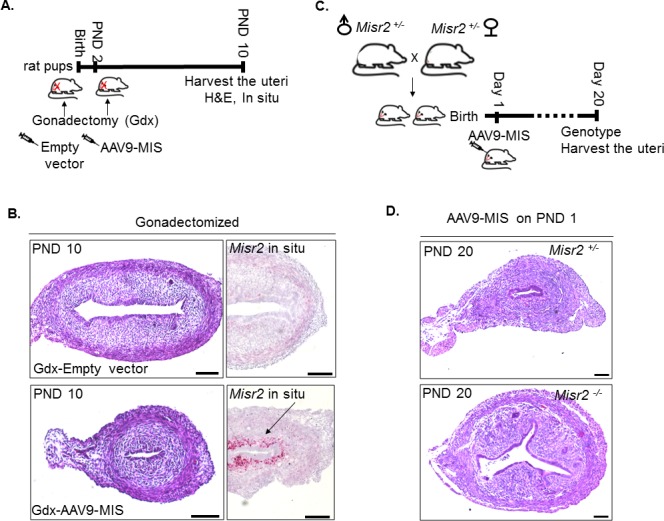
Uterine hypoplasia in response to treatment with exogenous MIS does not require ovaries and is dependent on MISR2.(A) Rat pups were gonadectomized on PND 2, and treated with empty vector (CTL) or AAV9-MIS (MIS) 6 hr after surgery. Gonadectomized (GDX) rats were sacrificed on PND 10 (n = 2 for each). (B) Representative transverse uterine section stained by H&E (left column) and Misr2 expression pattern by RNAish (right column) from GDX animals subsequently treated with CTL or MIS and analyzed at PND10. Scale bars = 100 µm. (C) Misr2cre/+ knock in cre recombinase bearing males and females were crossed to generate Misr2cre/cre mice, which are deficient in MISR2 (Misr2-/-). Mouse pups were injected with AAV9-MIS on PND 1, and euthanized on PND 20, and genotype was confirmed. (D) Transverse sections of the uteri of AAV9-MIS treated Mirs2+/-(Mirs2+/cre) heterozygous and Misr2-/- (Misr2cre/cre) homozygous mice were analyzed by H&E on PND 20. Note that the AAV9-MIS treated-Misr2-/- uteri do not present with hypoplasia. Scale bars = 100 µm.